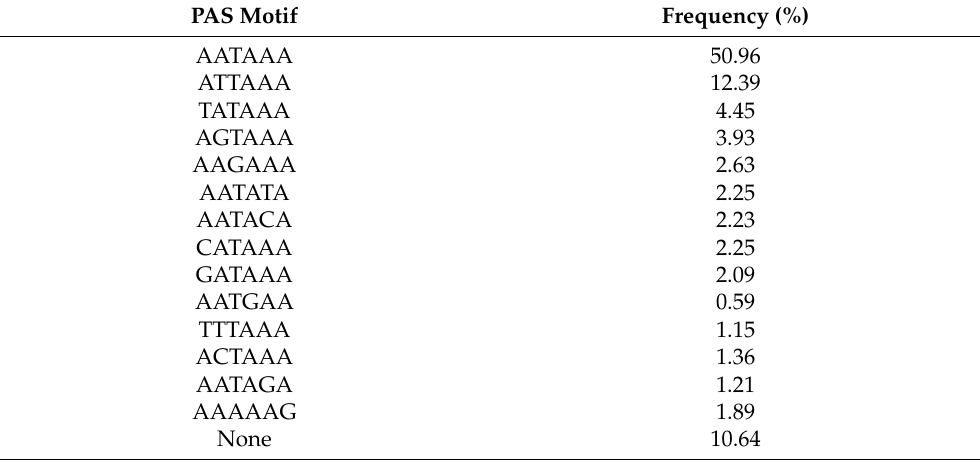
Figure 4. Distribution and number of random hexamers within the 100 bp of the cleavage site of the poly(A) tail-containing reads. Hexamer profiles upstream of the poly(A) sites to explore the candidate PAS sequences. The Y -axis represents the number of genes. Upstream of the poly(A) site was from − 100 to 100 relative to the CS at position 0. Table 2. Frequency (%) of PAS